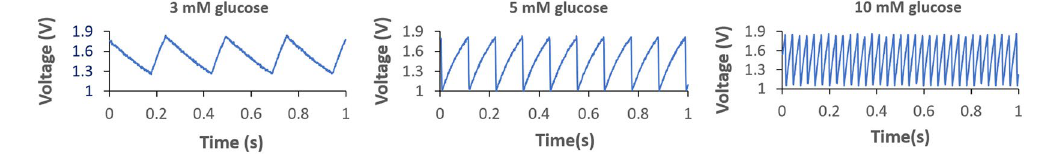
Figure 5. Effect of glucose concentration levels on the charging/discharging frequency of the capacitor connected to the charge pump operating in the presence of 3 mM, 5 mM and 10 mM glucose.